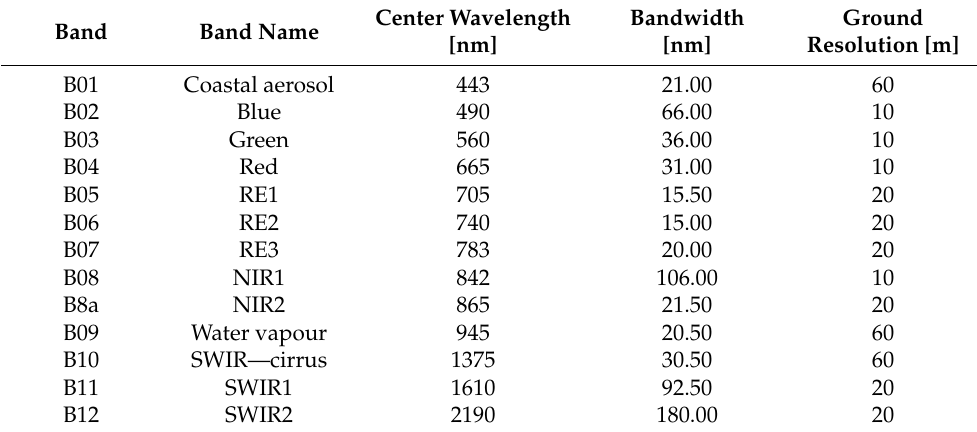
Table 2. The specifications of the Multispectral Instrument (MSI) on board the Sentinel-2 (S2) satellites (reproduced from the European Space Agency ESA). Band B10 was not used in the S2 resampled dataset as it lies within a region of atmospheric water